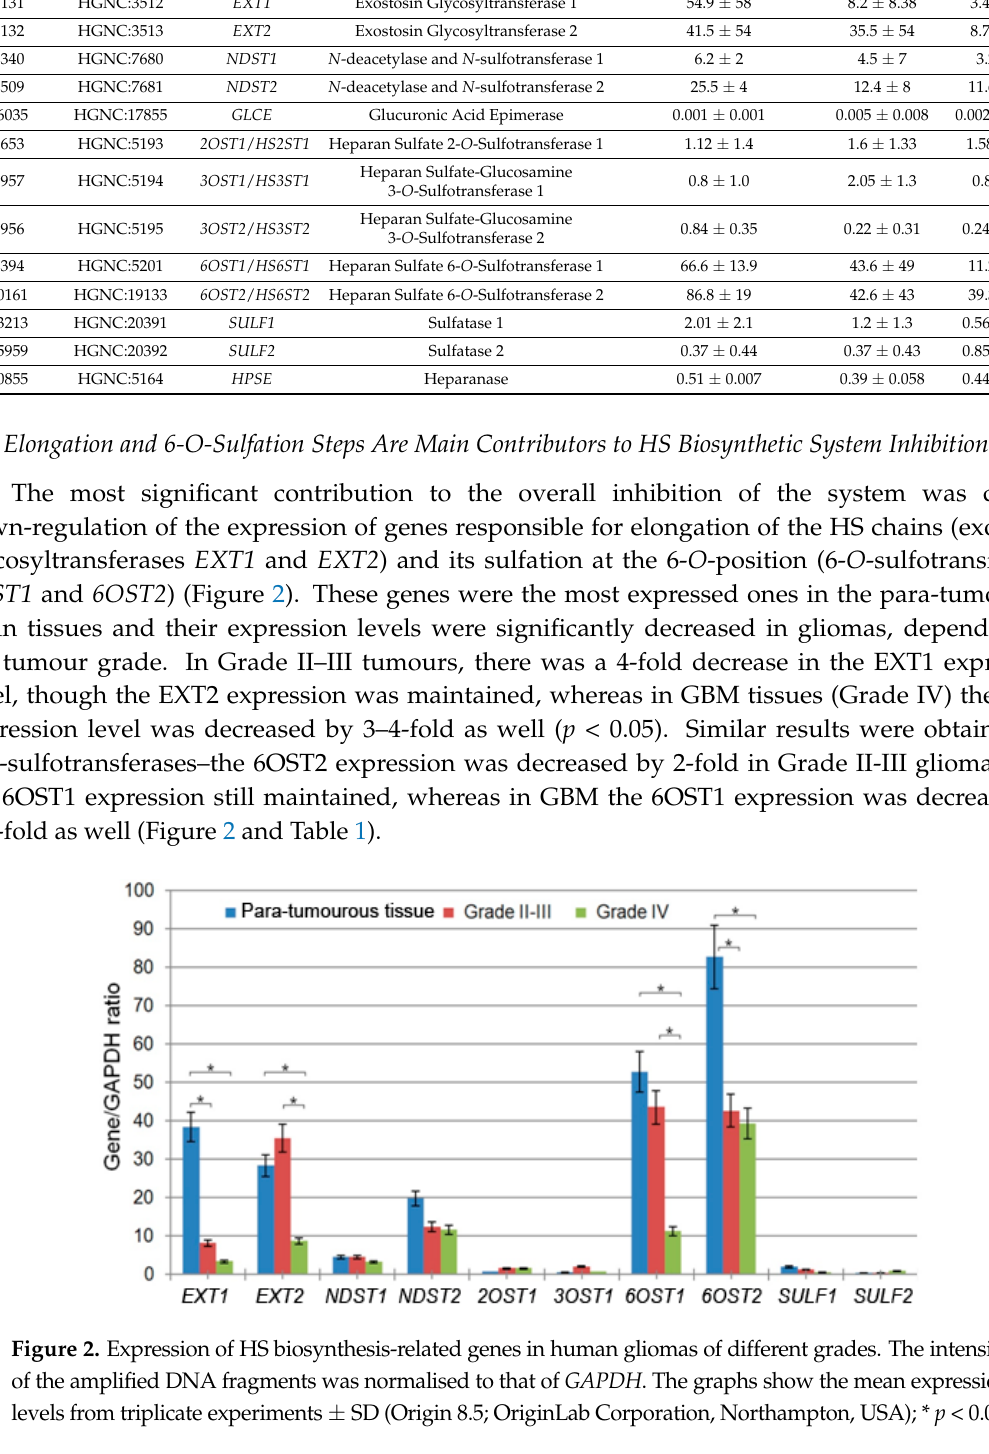
Table 1. Expression levels of HS biosynthesis-involved genes in glioma.